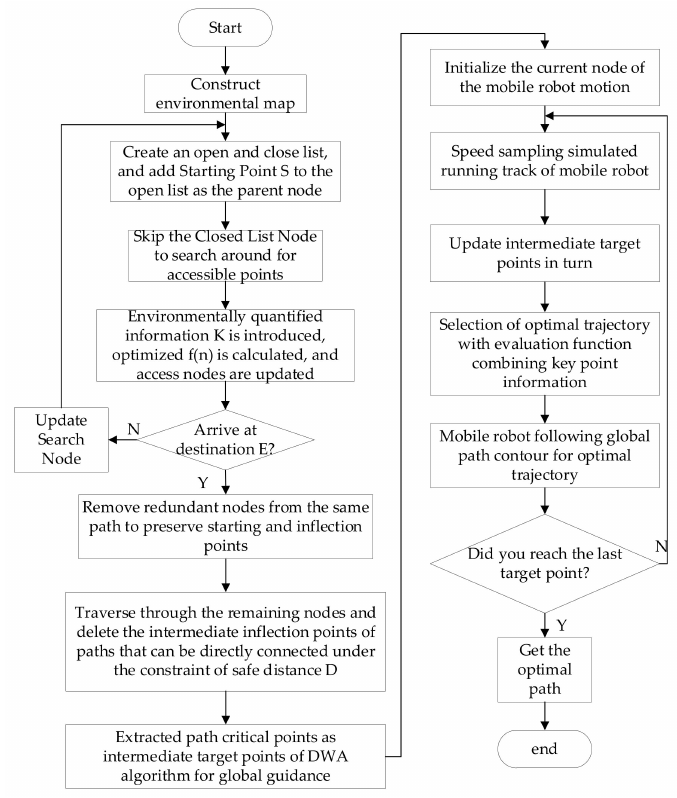
Figure 15. Hybrid algorithm flow